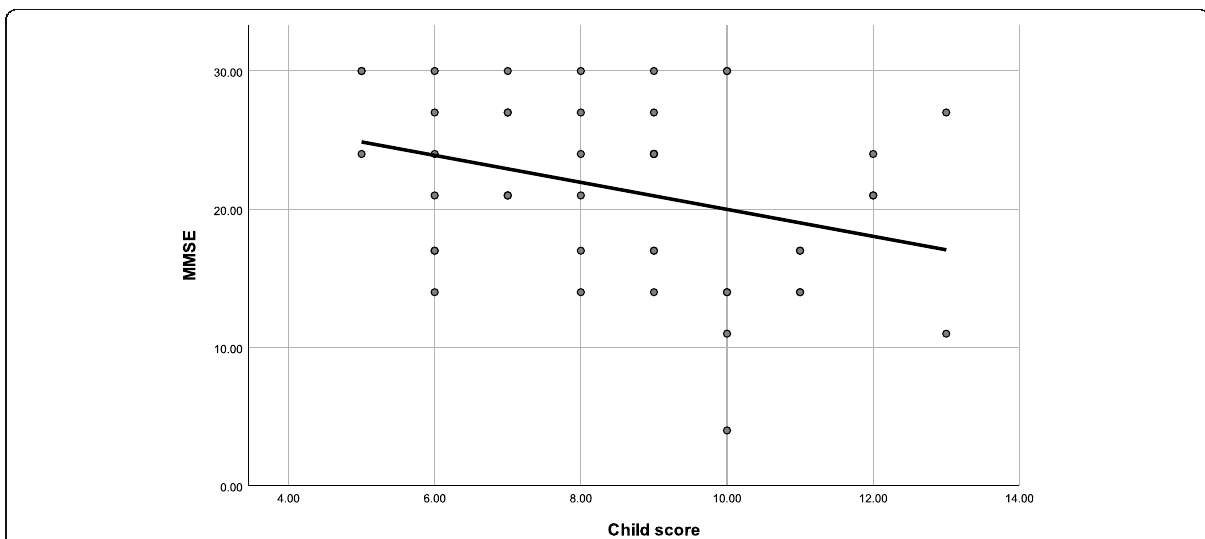
Fig. 2 The correlation between MMSE and Child score. BI Barthel index, MELD Model for End-Stage Liver